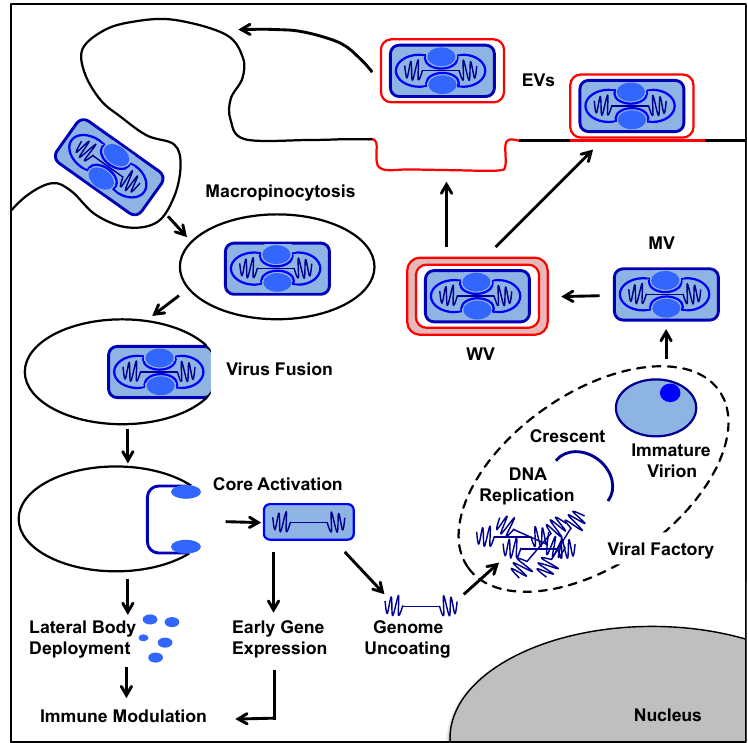
Figure 1. Vaccinia virus (VACV) replication cycle. The lifecycle of VACV begins when either, a single-membrane mature virion (MV) or double-membrane extracellular virus (EV), containing the genome, lateral bodies (LBs), and early transcription machinery, enters the host cell by inducing their own macropinocytic uptake. Upon fusion of the viral and the cellular limiting membrane of the macropinosome, the LBs dissociate from the core and are deposited in the cytoplasm. The LBs disperse, releasing virus host modulatory factors. Cores undergo activation concomitant with the initiation of early gene expression. Approximately